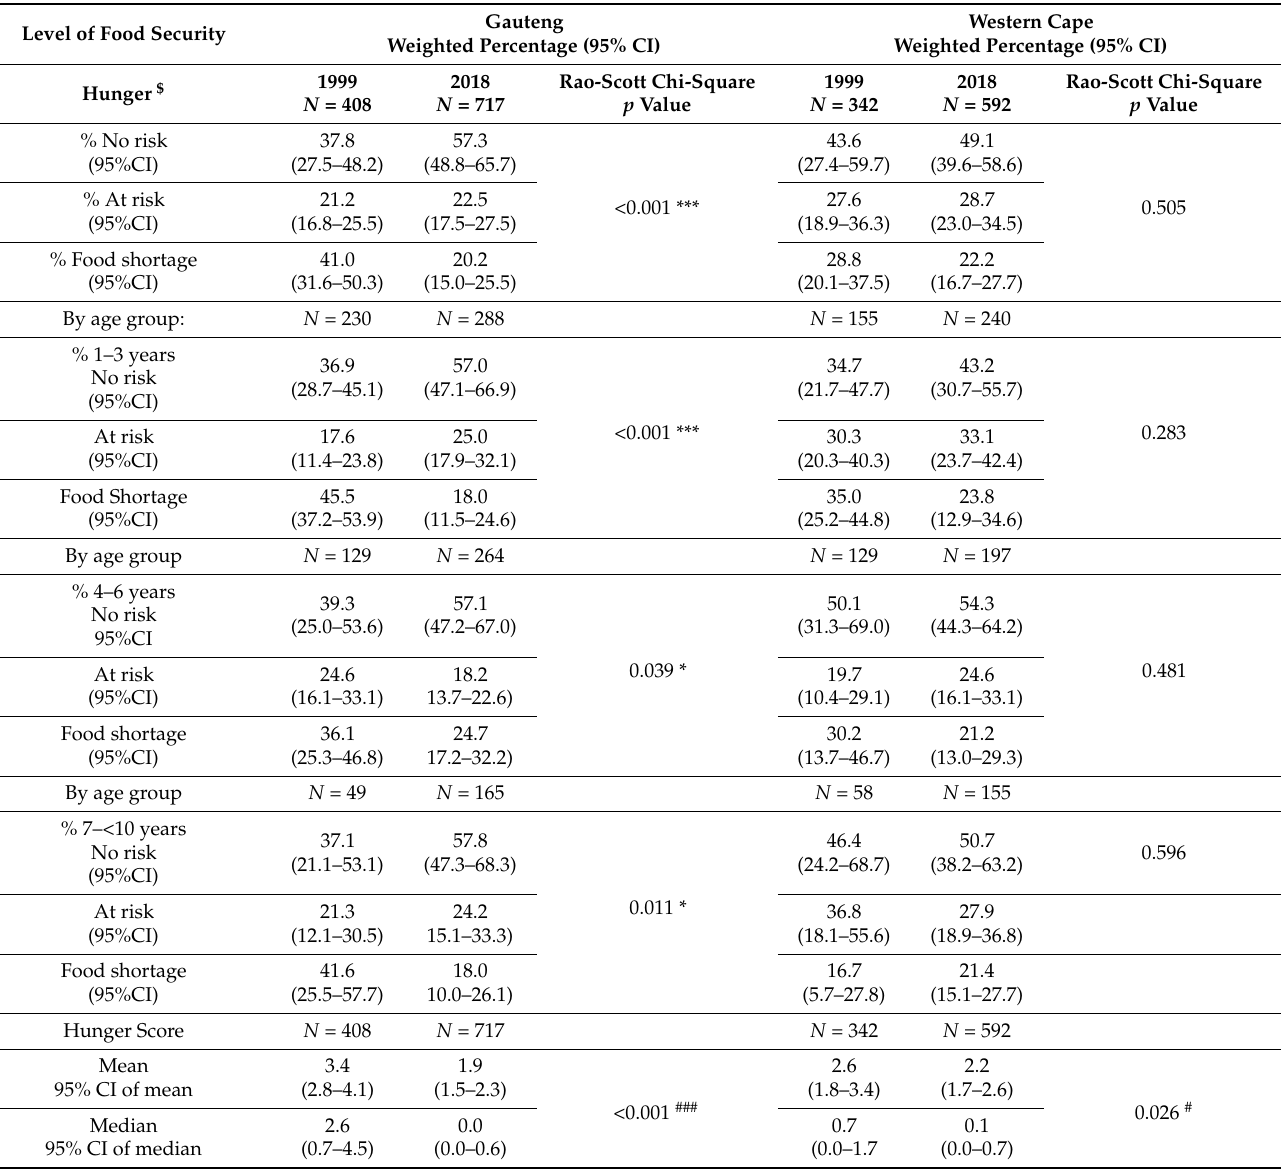
Table 2. Comparison of food security (hunger) of households in the Western Cape and Gauteng in 1999 and 2018 overall and by age